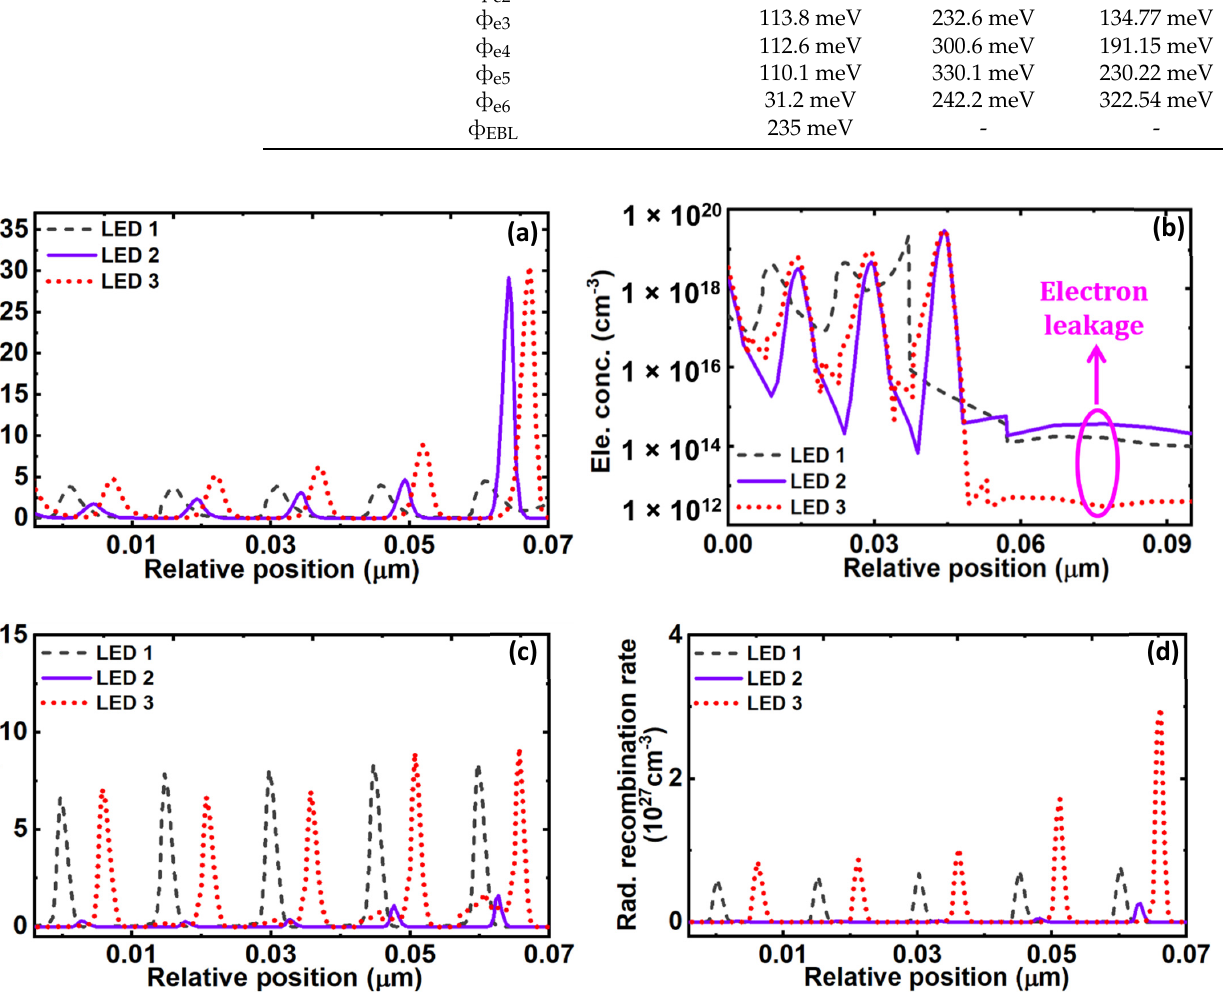
Figure 4. ( a ) Electron concentration, ( b ) electron leakage, ( c ) hole concentration, and ( d ) radiative recombination of LED 1, LED 2, and LED